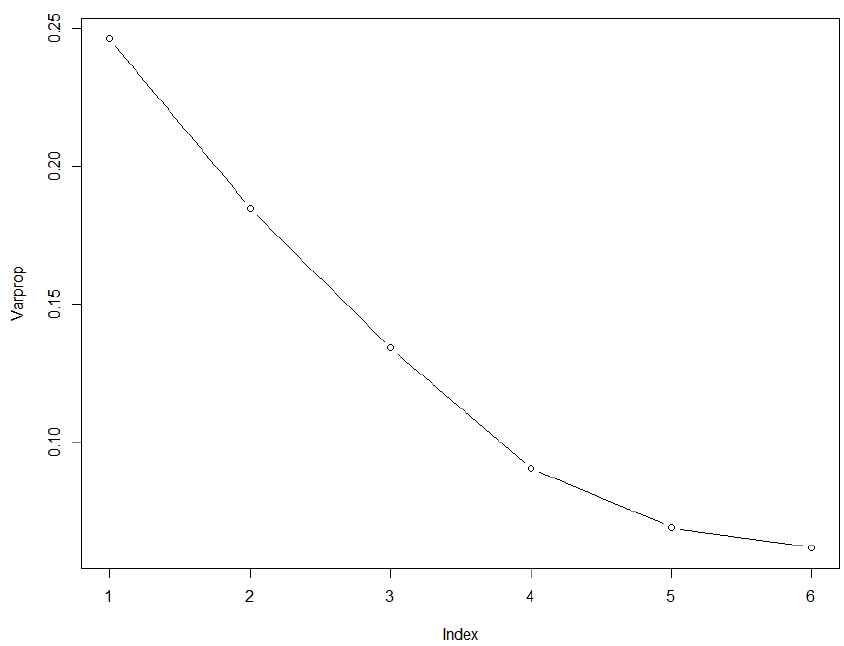
Figure 3. Variance proportions of FPCA. Note: Index: principal components (1st, 2nd, etc.); Varpro: variance proportions.